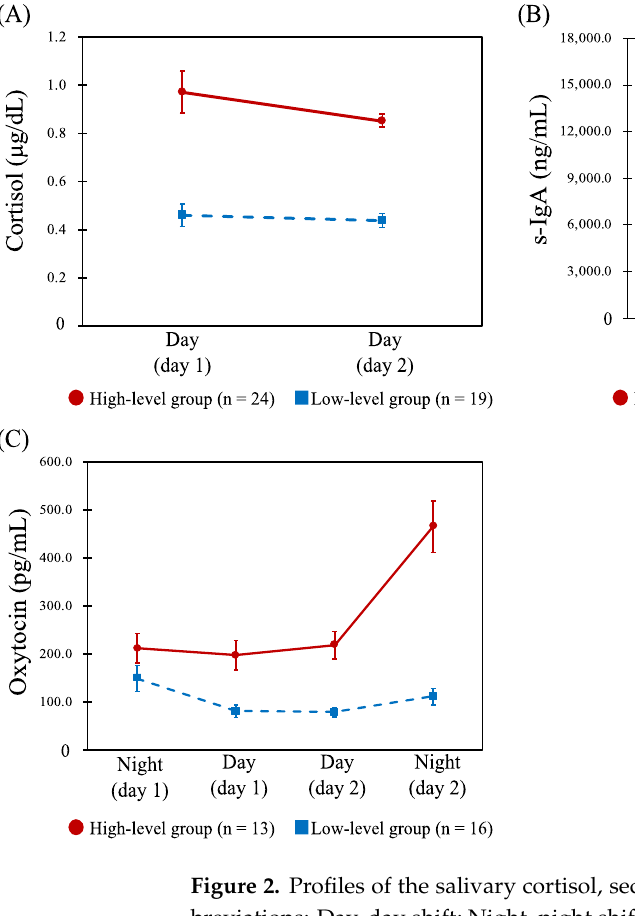
Figure 2. Profiles of the salivary cortisol, secretory immunoglobulin A (s-IgA), and oxytocin. Abbre- viations: Day, day shift; Night, night shift; s-IgA, secretory immunoglobulin A. Note: Data are shown as the mean (error bar, standard error of measurement) of each biomarker concentration. ( A ): Dynamics of the salivary cortisol concentration (μg/dL) between day shifts in the high-level ( n = 24) and low-level groups ( n = 19). ( B ): Dynamics of the s-IgA concentration (ng/mL) between the four shifts in the high- ( n = 21) and low-level groups ( n = 19). ( C ): Dynamics of the salivary oxytocin concentration (pg/mL) between the four shifts in the high- ( n = 13) and low-level groups ( n = 16).